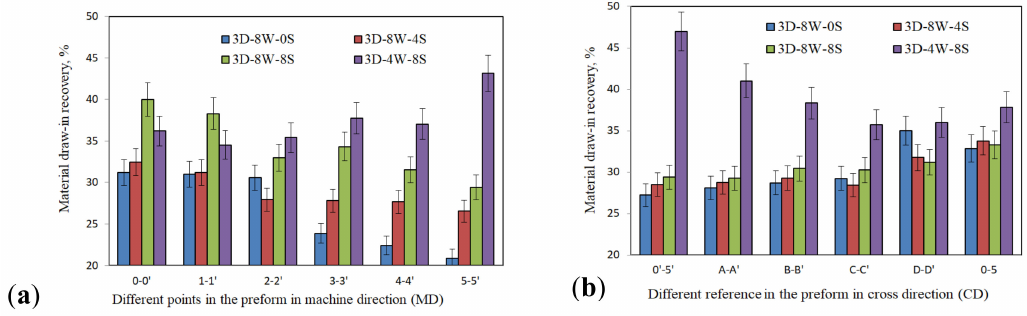
Figure 17. Influences of warp yarn inter-change ratio on the drawing-in recovery percentages of 3D warp interlock preforms at di ff erent points, ( a ) machine direction (MD) and ( b ) Cross direction